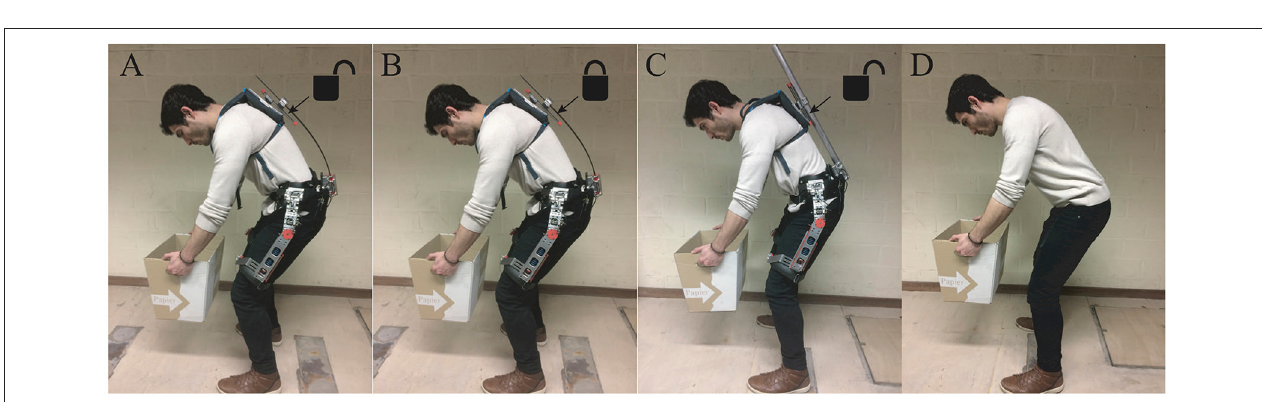
FIGURE 7 | Different exoskeleton configurations were tested: (A) Flexible exoskeleton with slider unlocked. (B) Flexible exoskeleton with slider locked. (C) Rigid exoskeleton with slider unlocked. (D) No exoskeleton. Written informed consent was obtained from the participant to publish this